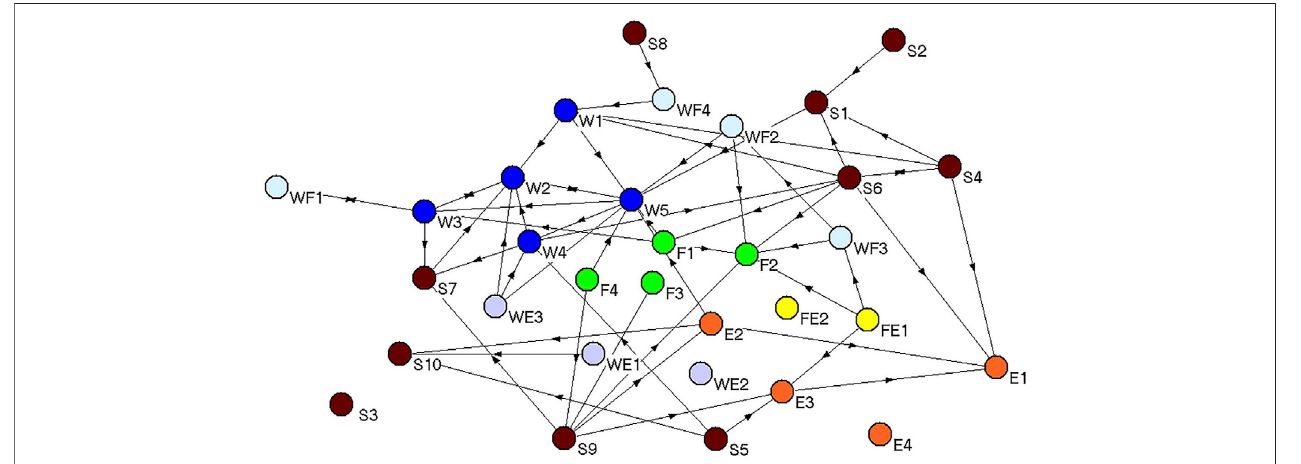
FIGURE 2 | The structure of indicators for the water-energy-food